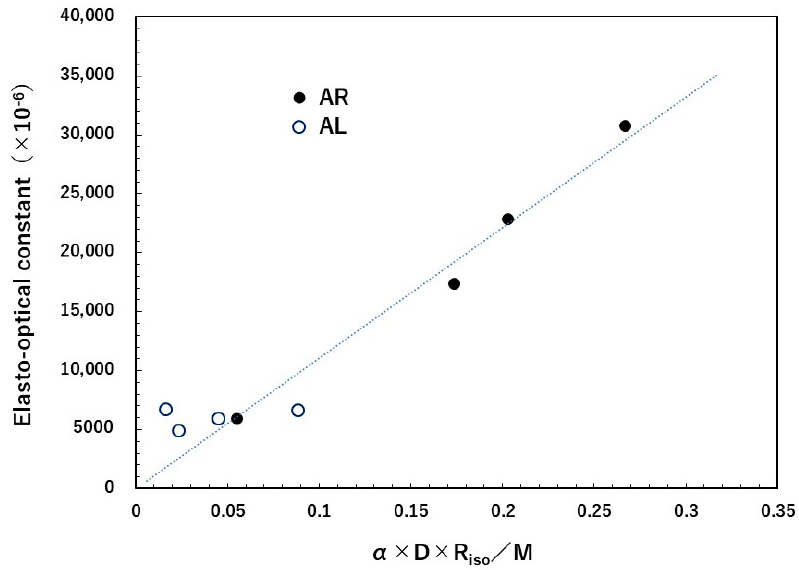
Figure 7. Relationship between α × D × R iso / M and the elasto-optical constant of polyurethanes.